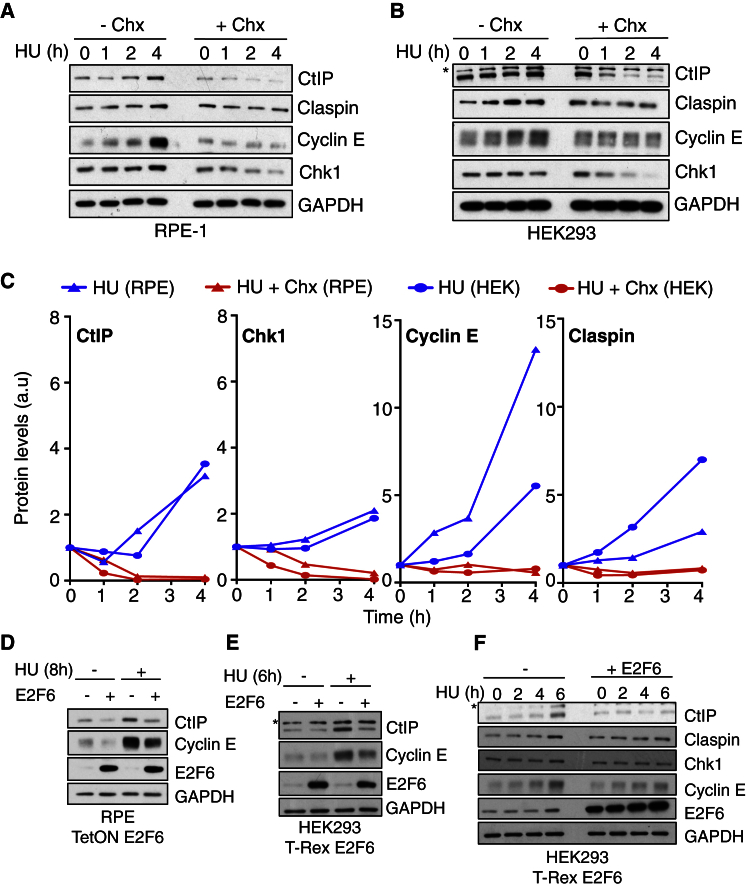
E2F Transcription and Active Protein Synthesis Are Required to Maintain and/or Upregulate the Levels of Checkpoint ProteinsAsterisks mark unspecific bands.(A) Western blot of WCE (whole-cell extract), RPE1 cells, treatment, and times shown.(B) Western blot of WCE, HEK293 cells, treatment, and times shown.(C) Quantification of (A) (RPE1) and (B) (HEK293), normalized to GAPDH and 0 hr.(D) Western blot of WCE, RPE1 TetON E2F6 cells, treatment, and times shown. E2F6 overexpression, Doxy.(E) Western blot of WCE, HEK293 T-Rex E2F6 cells, treatment, and times shown.(F) Western blot of WCE, HEK293 T-Rex E2F6 cells, treatment, and times shown.See also Figure S3.